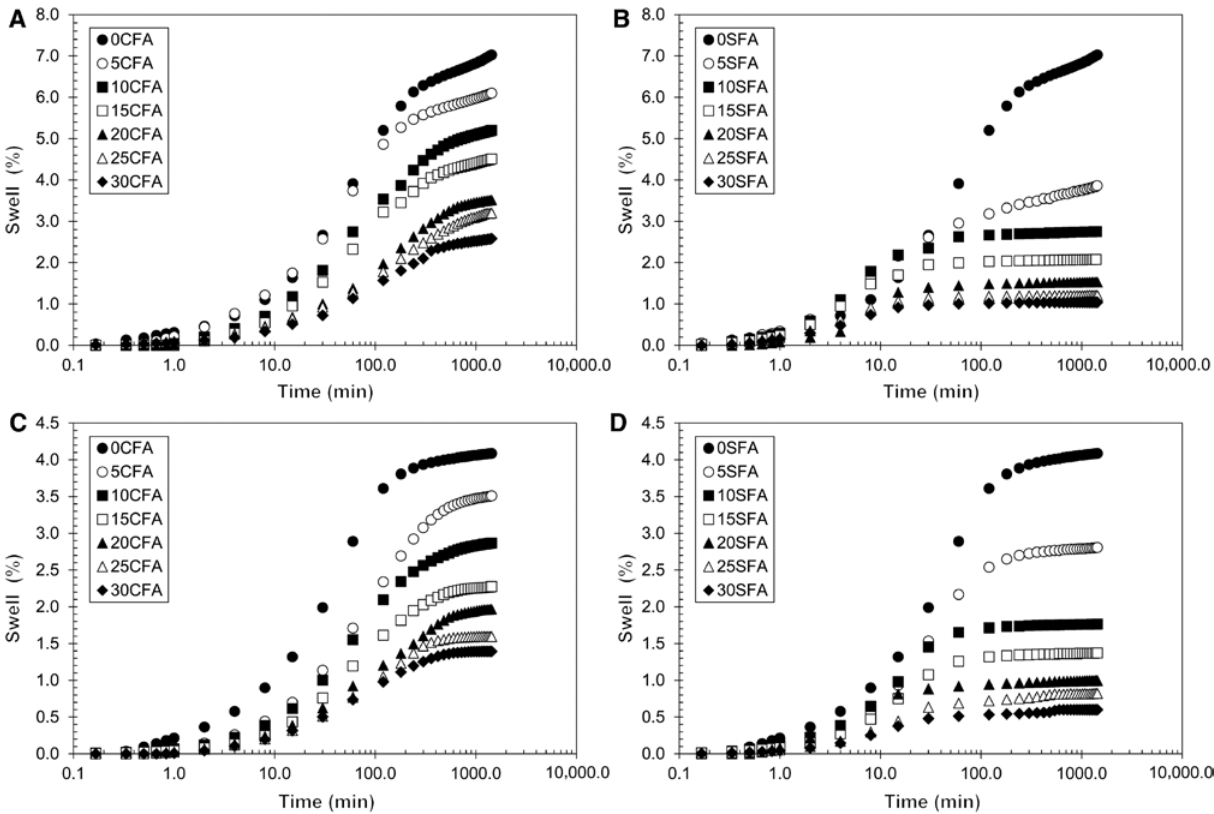
Figure 7: Swell percentage versus time plots for mixtures (A) Soil A-CFA mixtures, (B) Soil A-SFA mixtures, (C) Soil B-CFA mixtures and (D) Soil B-SFA